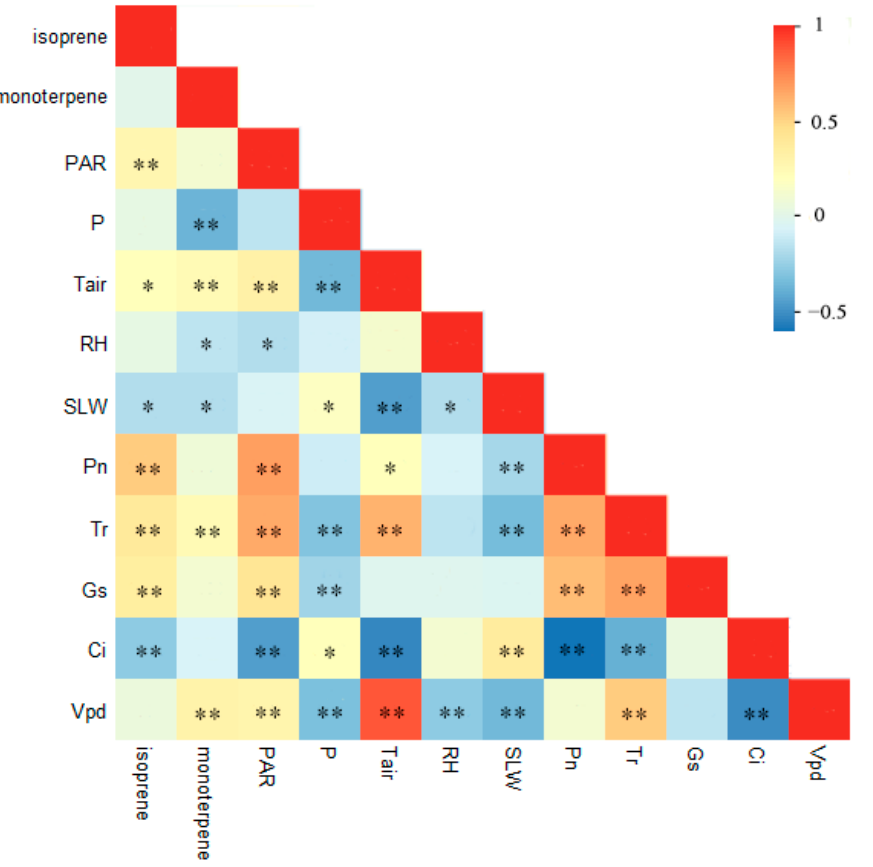
Figure 5. Pearson’s correlations among the isoprene and monoterpene emission rates and the envi- ronmental factors and plant ecophysiology. * is significant at p ˂ 0.05; ** is significant at p ˂ 0.01.